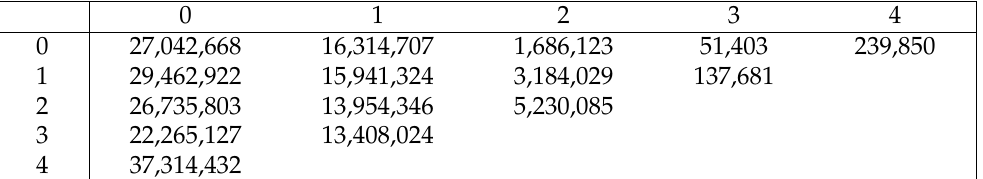
Table 15. Triangle of non-cumulative payments after the adjustment by the heat equation in one